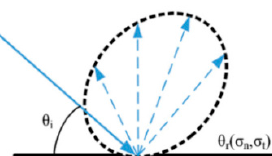
Figure 2. Reflected velocity distribution of impacted molecules described by CLL